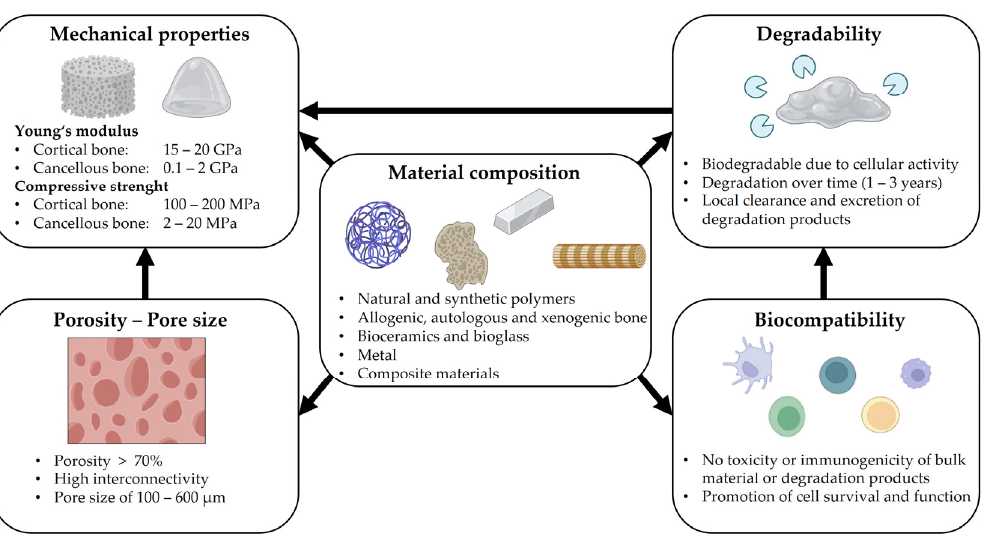
Figure 1. Parameters that need consideration in scaffold design and their interplay. Figure contains illustrations and icons created with BioRender.com (accessed on 8 December 2022).